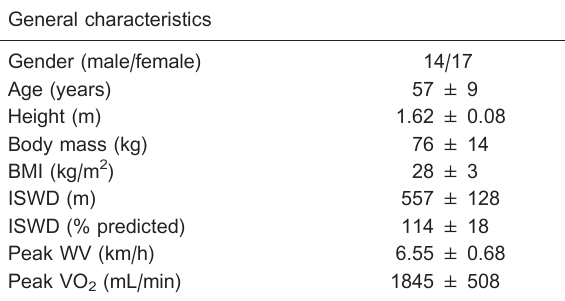
Figure 2. Agreement between walking velocity (WV) at heart rate variability threshold (HRVT) and ventilator threshold (VT) obtained in the 2nd (WV-HRVT2) and 3rd (WV-VT) incremental shuttle walk